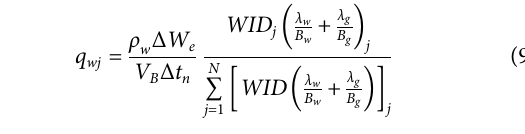
Frontiers in Energy Research |